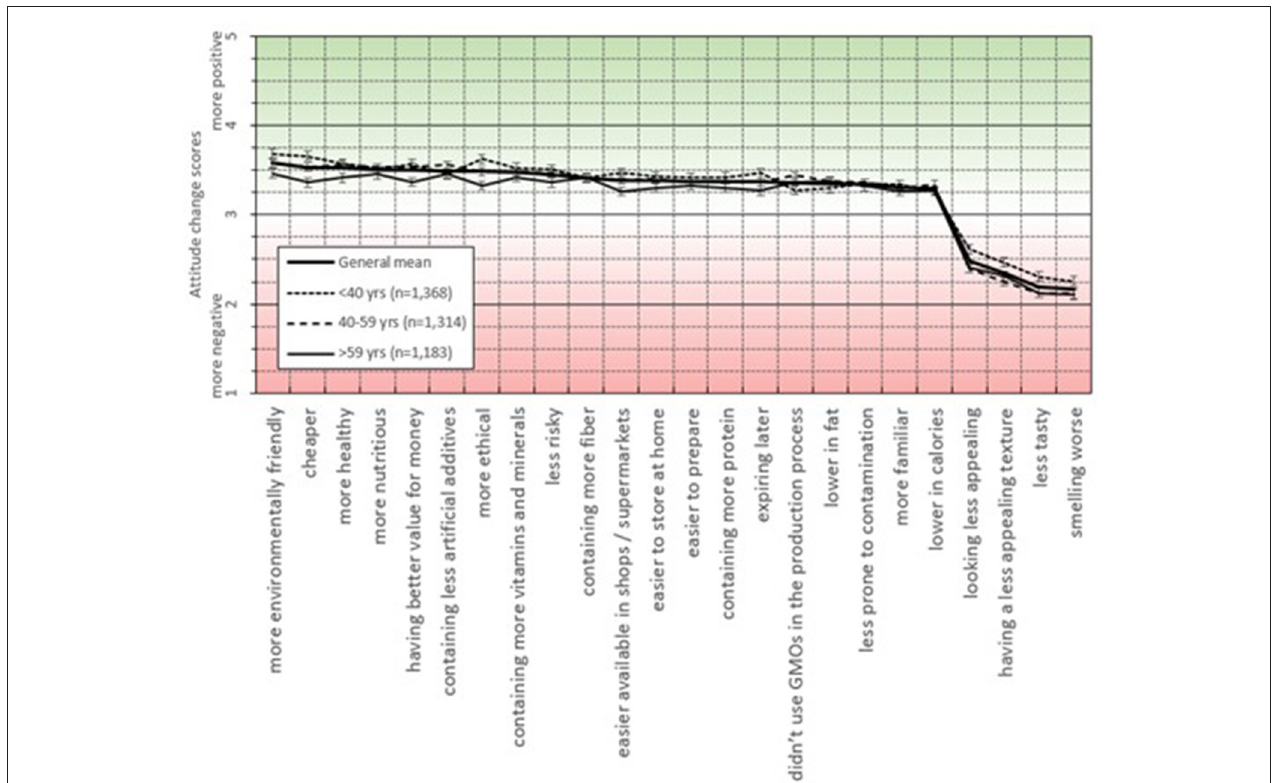
FIGURE 8 | Differences between age groups. The error bars represent 95% credibility intervals estimated with Bayesian